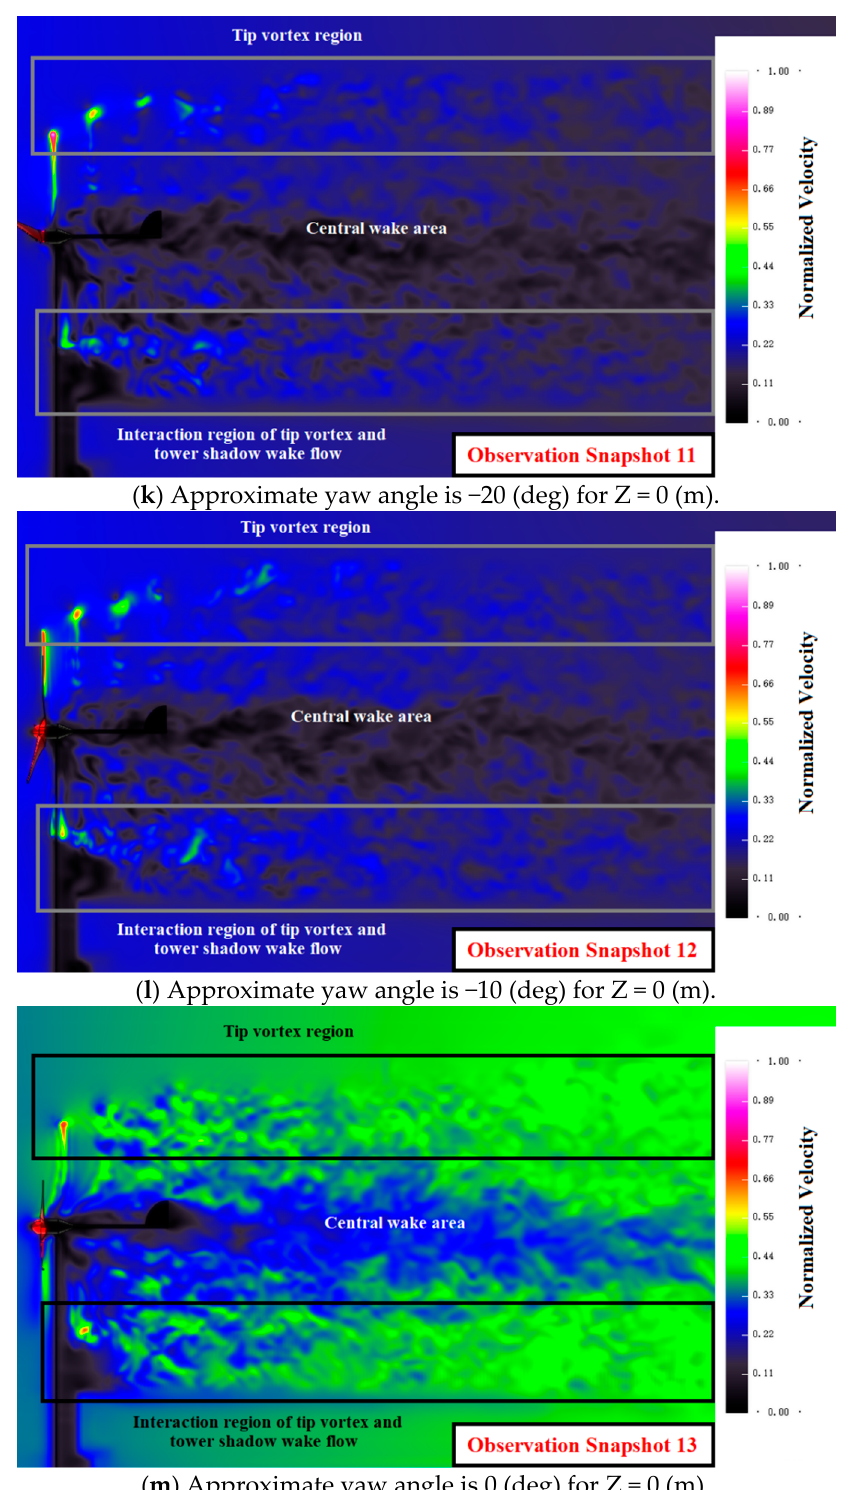
Figure 10. Transient wake of the selected snapshots at Z = 0 (m) in the yawing situation. When the yaw angle reaches about 20 (deg), corresponding to snapshot 3 in Figure 10c, the position and shape of the tip vortex are more distinct in the near wake, and the speed loss zone in the central wake area is basically formed, corresponding to the blue area in the center in Figure 10c. The radial outward movement of the tip vortex is captured, but the symmetry of the tip vortex in the upper and lower parts of the near wake is